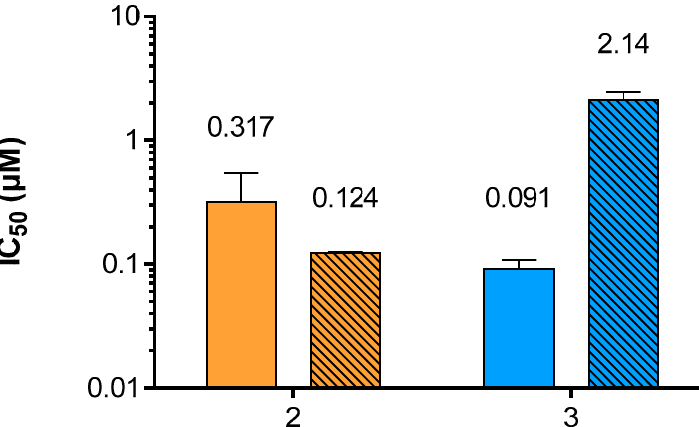
Figure 3. Evaluation of compounds 2 and 3 potencies to inhibit hPIV-1 HN neuraminidase and haemagglutinin functions. Inhibition of hPIV-1 HN neuraminidase (plain) and haemagglutinin (stripes) functions by inhibitors 2 and 3 . The values presented are the mean of 3 independent experiments; the calculated standard deviation (SD) is represented by the error bars.